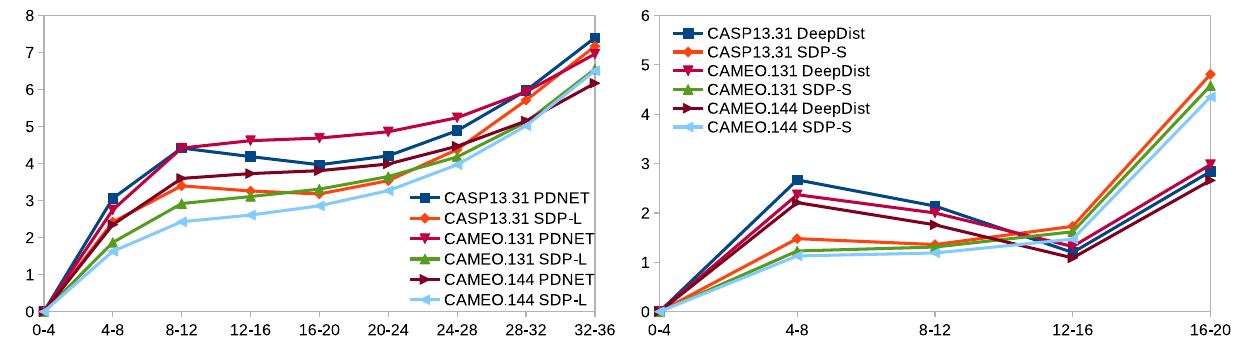
Figure 4. MAE values (y-axis) in various split actual distance ranges (x-axis) for PDNET and SDP-L (left) and for DeepDist and SDP-S (right). The right chart includes the range 16–20 Å to show the very sharp increasing trend in the later